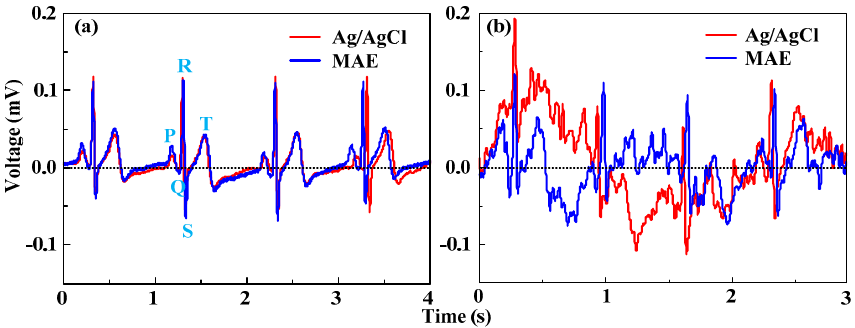
Figure 10. ECG signals recorded: ( a ) in the static state, and ( b ) in the dynamic state.